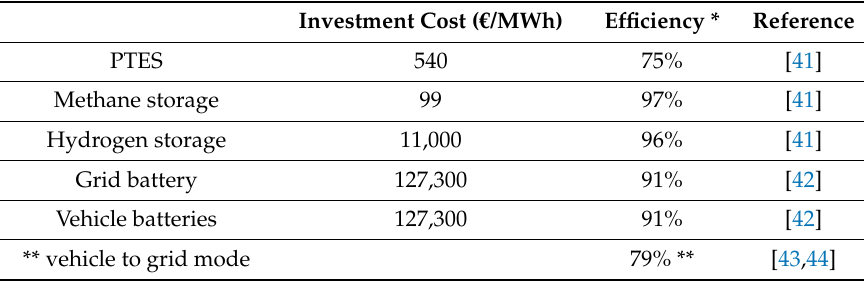
Table 2. Investment costs and efficiency of different storage